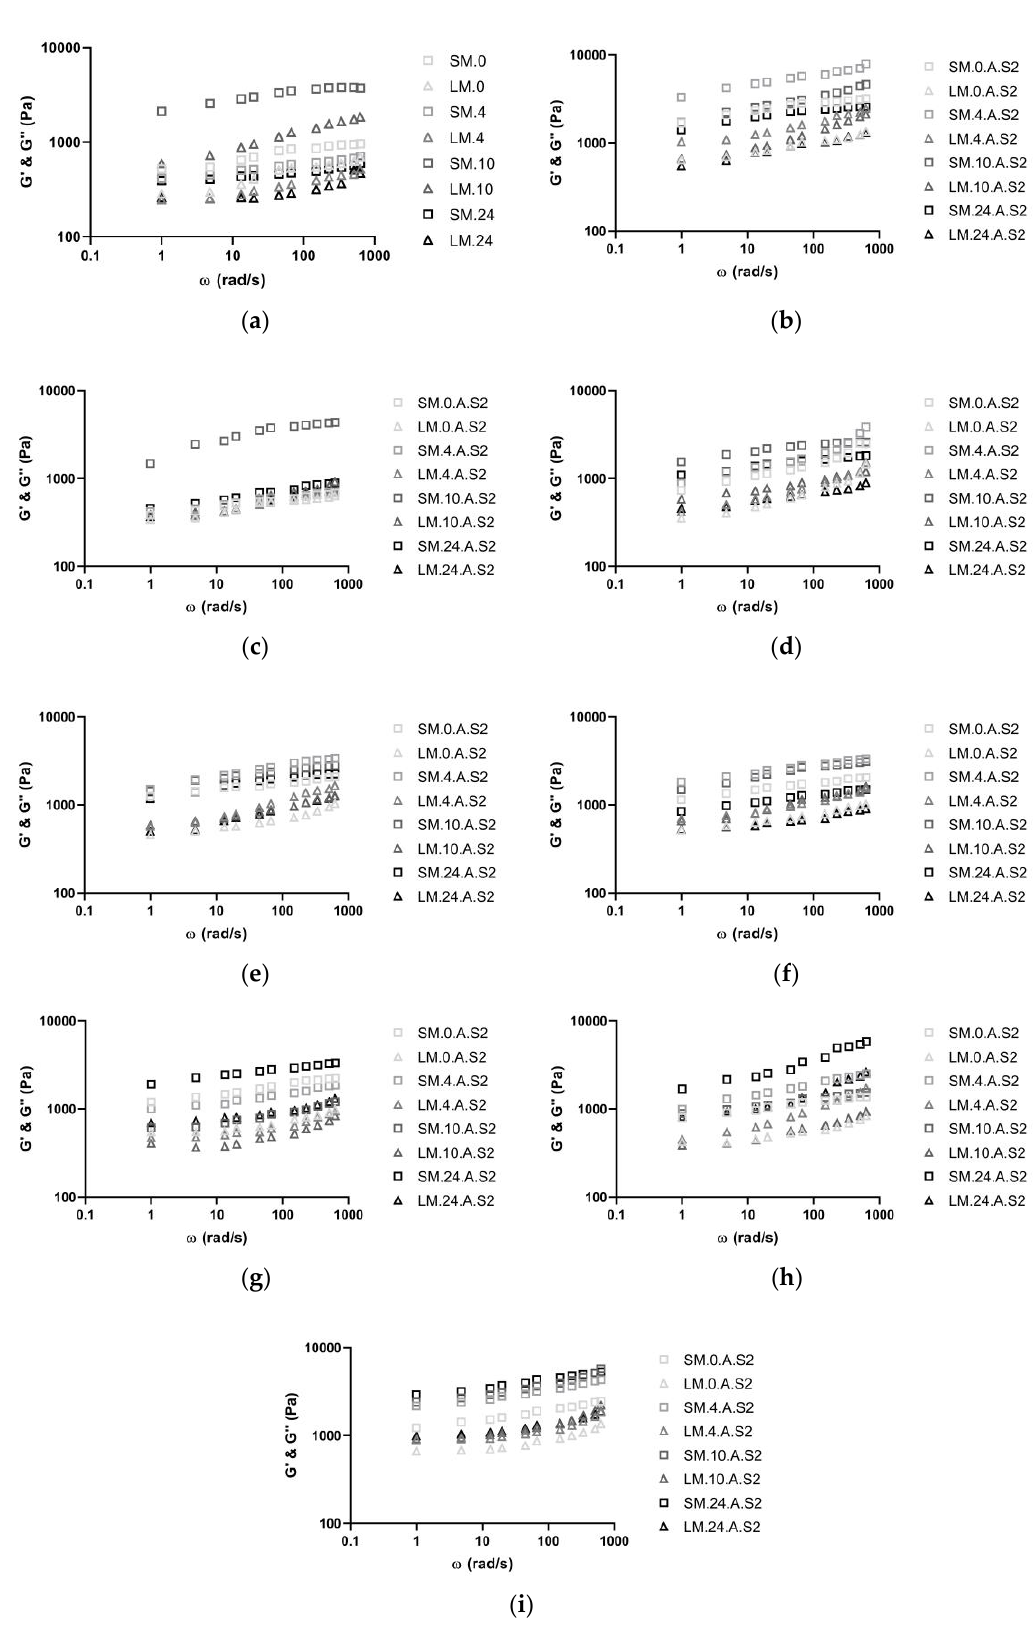
Figure 3. The storage (G’) and loss (G”) shear moduli for sourdoughs fermented in 100% wheat flour with ( a ) Lp , ( b ) Lc , and ( c ) Lp + Lc + Sc ; 95% wheat + 5% soy flour with ( d ) Lp , ( e ) Lc , and ( f ) Lp + Lc + Sc ; and 90% wheat + 10% soy flour with ( g ) Lp , ( h ) Lc , and ( i ) Lp + Lc + Sc through 24 h . Wheat flour combined with water results in a hydrated gluten network that gives the viscoelastic property of sourdough. The right amount of water is important in sourdough preparation, and due to non-miscible properties of wheat biopolymers, it is present in each phase of bread making [54]. The study of sourdough rheological properties is associated with different wheat or other types of flours and their water absorption capacity [55]. Sun et al. [56] modeled the viscoelastic behavior of a broad range of doughs prepared in different formulations. According to this study, with the increase of water content, the viscosity decreases. Hardt et al. [55] found that the reduction of water content from 43.5% to 34% caused a positive growth in dough consistency, and a similar result was obtained with the increase of xylanase addition. The effect of fermentation with different Lp strains proved that through fermentation of whole wheat bread, the quality and shelf life of bread could be improved. In this study, with the use of Lp LB-1 stronger extensibility, increased viscoelasticity, and water retention ability was obtained. The production of organic acids and the decrease of pH influence the rheological properties, and reduce mixing time, which causes an increased elastic behavior [57]. Soybean flour addition increased the overall organic acid production, with each single or co-culture, and, as a consequence, influenced positively the elastic behavior of sourdough. Zhou et al. [58] reported enhanced stability and elasticity of wheat dough enriched with soy-protein that provided an increased water-binding ability. As stated, soy-protein strengthens the disulphide linkage, offering better elasticity for baked products. 3.3. Organic Acid and Secondary Metabolite Analysis by HPLC LAB greatly influences the sensory, textural, nutritional, and shelf-life characteristics of sourdough baked goods, especially bread [59]. For a long time, the improved shelf life of sourdough baked products was attributed to the lactic and acetic acids produced by LAB [60,61]. Further studies [62–64] have shown that lactic acid is not inhibitory to fungi, while the acetic acid concentration seems to be more strictly related to the antifungal activity [40]. Acetic acid through sourdough fermentation also enhances the aroma profile of bread [65]. The acetic acid concentration in sourdough may be increased by adding fructose, which is used as an external electron acceptor by heterofermentative LAB, which consequently increases the growth yield and acetic acid production [40].